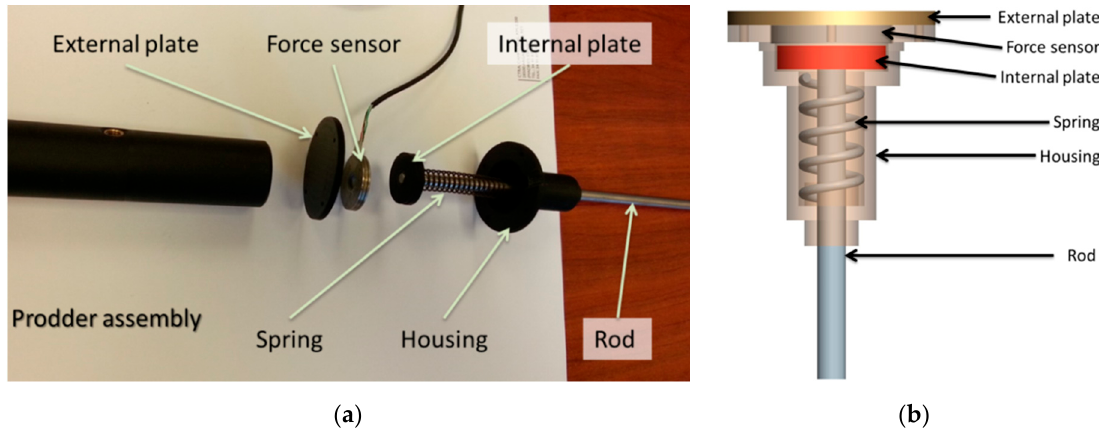
Figure 1. Custom-made installation of the load cell: ( a ) Real disassembled view of the different elements that compose the described design; ( b ) Detailed drawings of the custom-made installation.